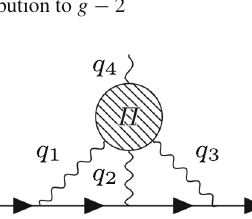
Fig. 3 HLBL contribution to g −